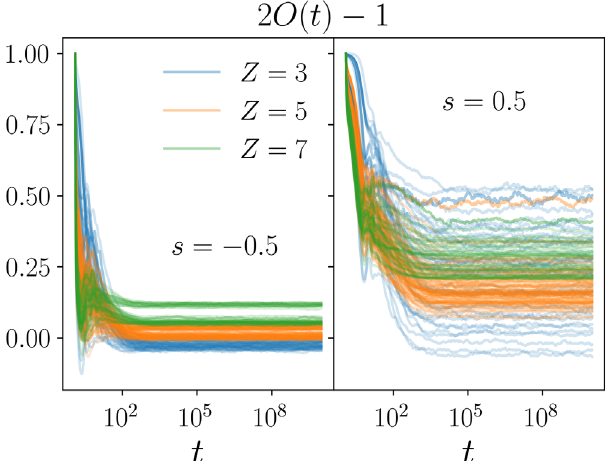
FIG. 1. Fast vs slow dynamics in the quantum East model. Relaxation to equilibrium of (time-averaged) density autocorre- lator (2) starting from all possible product initial states for N ¼ 10 . For s < 0 (left panel) equilibration is fast, and memory of the initial conditions is rapidly lost. For s > 0 (right panel), relaxation is slow, and memory of initial conditions is preserved throughout the simulation